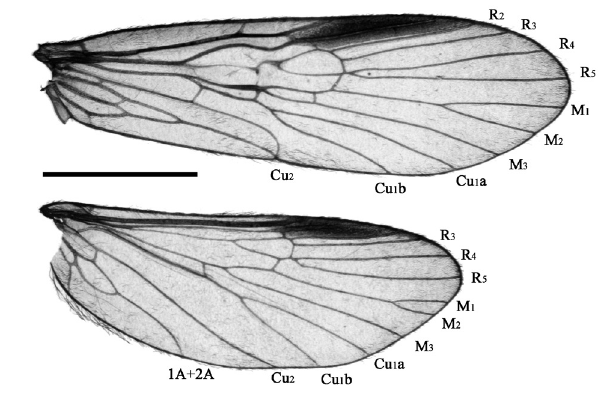
Fig. 1. Chimarra jejyorum sp. nov., right wings. Scale bar =